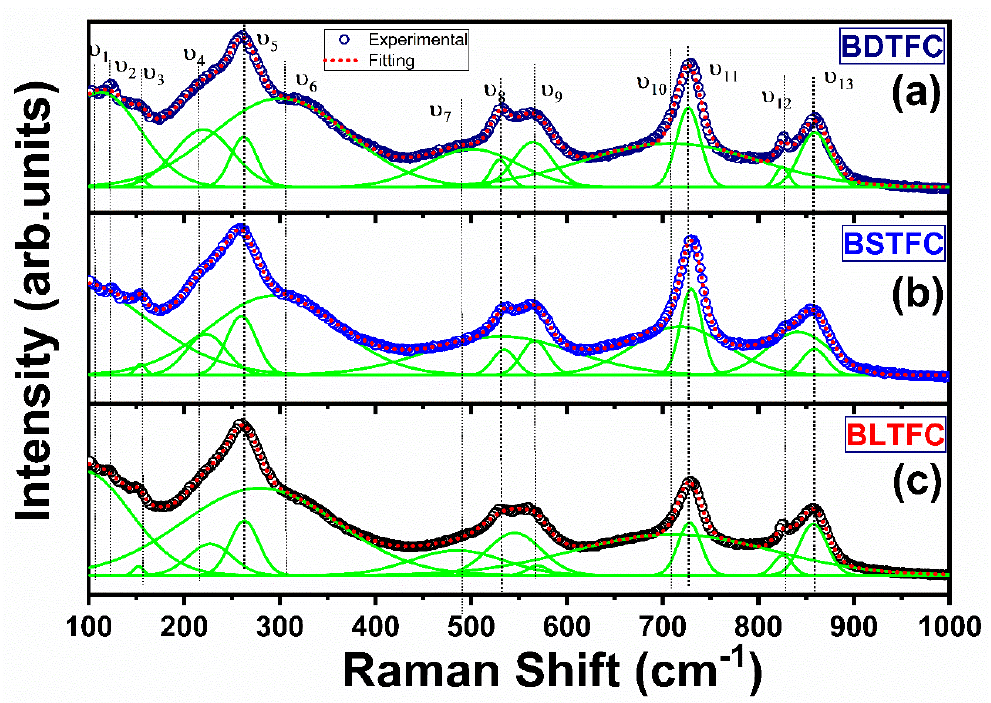
Figure 4. ( a – c ) Raman spectra of BDTFC, BSTFC, and BLTFC samples (green lines indicate deconvoluted curves).